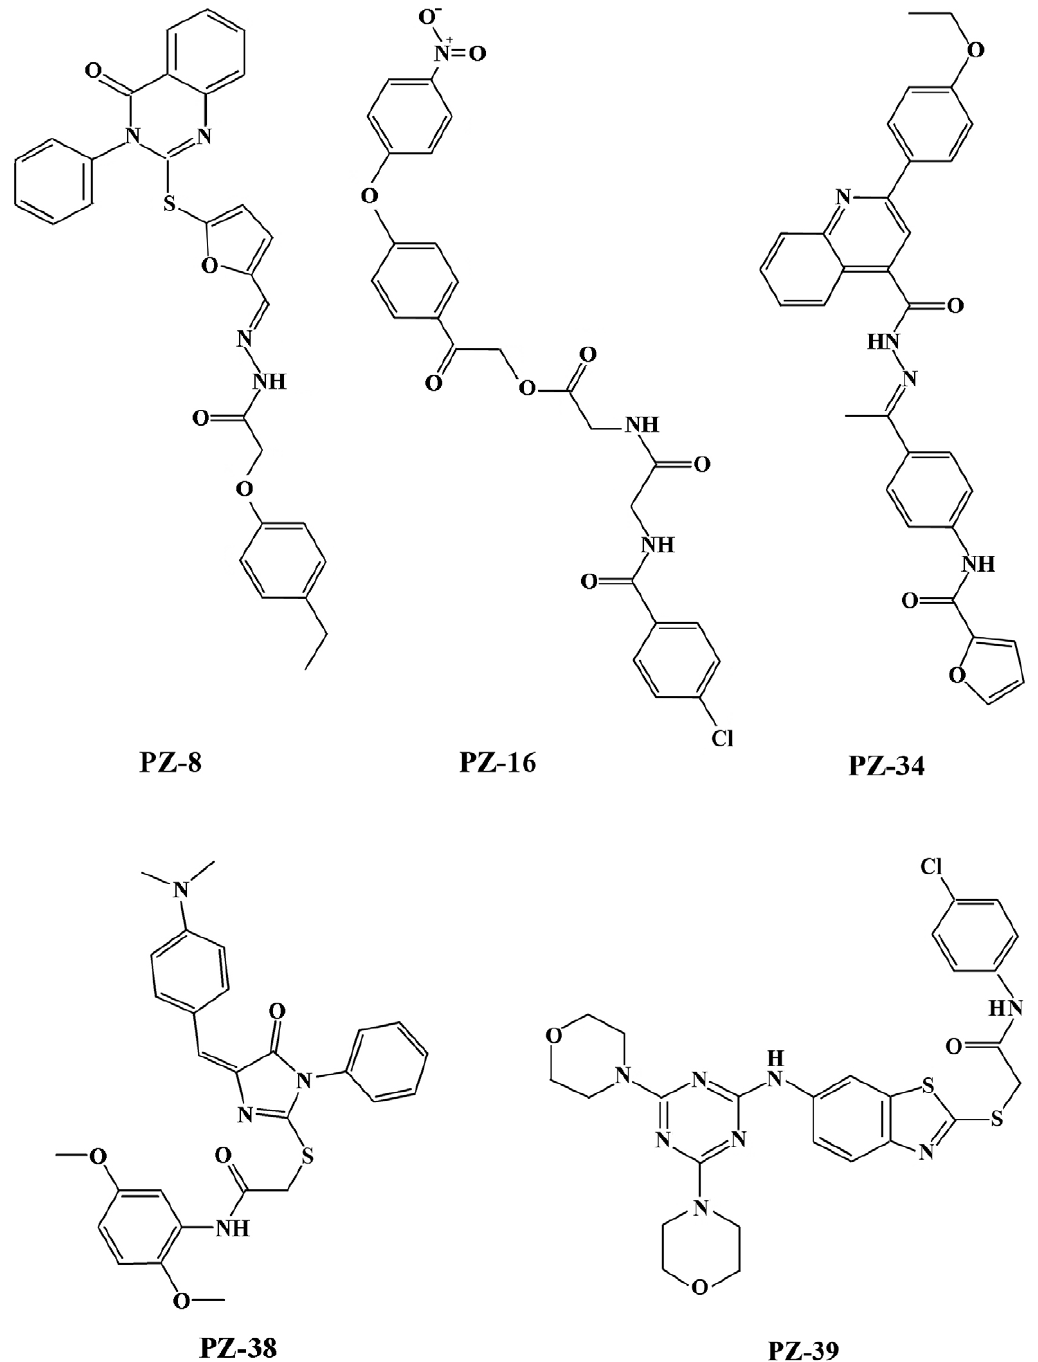
Figure 1. Structures of PZ-8, 16, 34 and 38 in comparison with PZ-39. The chemical structures are shown for PZ-8, (12E)-N’-((5-(3,4-dihydro-4- oxo-3-phenylquinazolin-2-ylthio)furan-2-yl)methylene)-2-(4-ethylphenoxy)acetohydrazide; PZ-16, 2-(4-(4-nitrophenoxy)phenyl)-2-oxoethyl2-(2-(4- chloro benzamido)acetamido)acetate; PZ-34, (E)-2-(4-ethoxyphenyl)-N’-(1-(4-(furan-2-carboxamido) phenyl)ethylidene)quinoline-4-carbohydrazide; PZ-38, (N-(2,5-dimethoxyphenyl)-2-({4-[4-(dimethylamino)benzylidene]-5-oxo-1-phenyl-4,5-dihydro-1H-imidazol-2-yl}sulfanyl)acetamide); and PZ-39 (N-(4-chlorophenyl)-2-[(6-{[4,6-di(4- morpholinyl)-1,3,5- triazin-2-yl] amino}-1,3-benzothiazol-2-yl)sulfanyl]acetamide). doi:10.1371/journal.pone.0015276.g001 does not. Together with our previous finding that FTC inhibits only ABCG2 activity [7], we conclude that there are likely two types of ABCG2 inhibitors with one inhibiting only ABCG2 activity while the other inhibiting both the activity and expression of ABCG2.